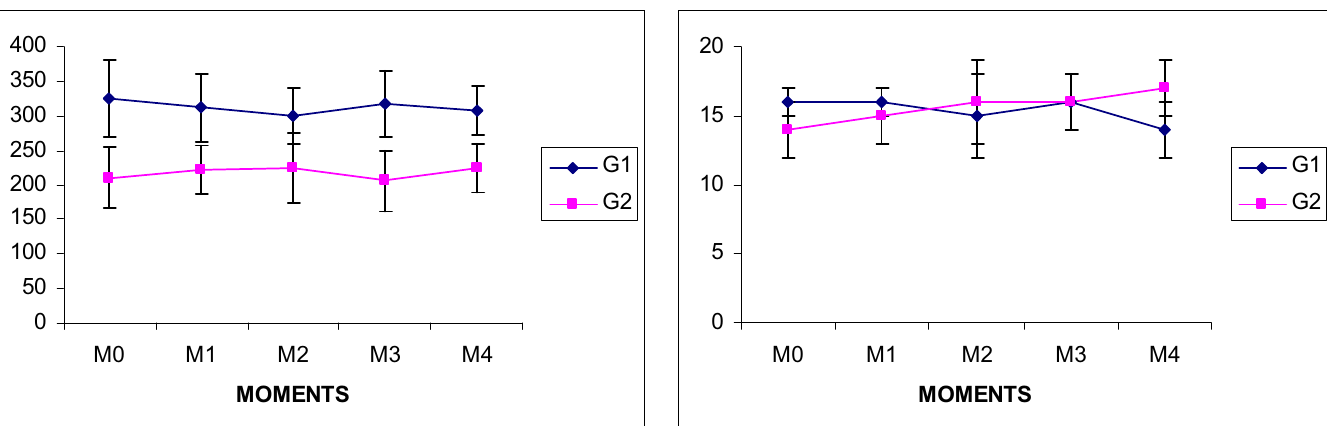
FIGURE 1 - Mean body weight for groups 1 and 2 at the experimental moments